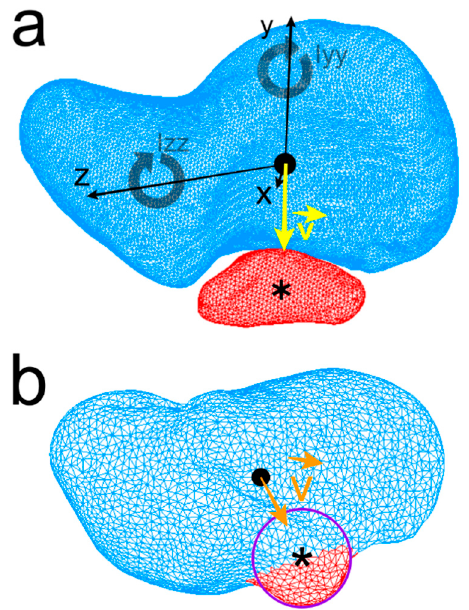
Figure 3. Centroid of the human scaphoid (black round dot), os centrale (Asterisk), I xx , I yy , I zz : the moments of inertia of the scaphoid about its three axes x, y, z are represented. The direction vector 𝑣 (cid:4652)(cid:4652)(cid:4652)⃗ (yellow) is drawn from scaphoid centroid towards the os centrale centroid ( a ). Neandertal scaphoid, a curve modeling the small semi-circular projection of the distal border of the scaphoid was drawn and centroid of the curve (approximation of the os centrale centroid) was computed and vector 𝑣 (cid:4652)(cid:4652)(cid:4652)⃗ (orange) is drawn in the same manner ( b ). Centroids of the scaphoids of each model were positioned at the origin (0, 0, 0) with